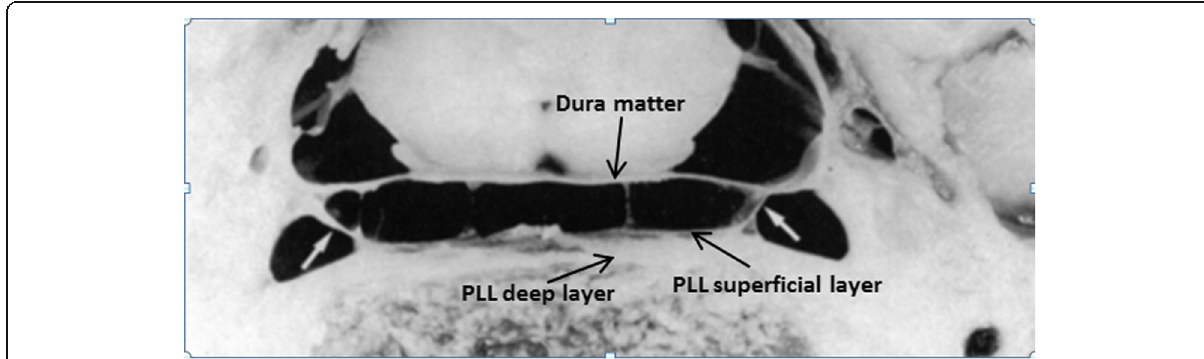
Fig. 1 A cadaveric cross section of the cervical spinal canal. The white arrow denotes the connection between the superficial layer of the PLL and the dura